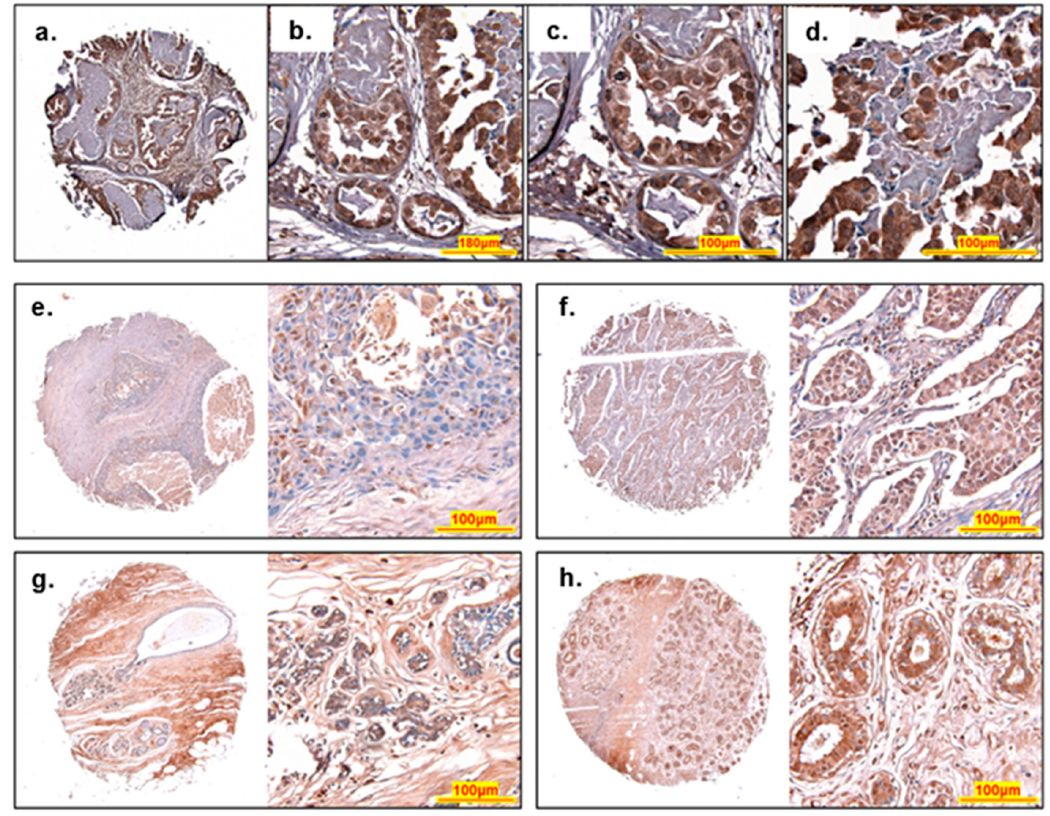
Figure 7. Histology of ACBD3 stained breast cores. ( a – d ) An invasive carcinoma from a 39-year-old female, stage IIA, ER- PR- HER2 2+ reveals a pattern of differential ACBD3 staining (brown), haematoxylin was used a as a nuclear stain (blue). ( a ) Low magnification image of entire core, fibrous interlobular tissue has a low level of ACBD3 staining whilst breast duct acini have high levels of ACBD3 staining. ( b ) Medium magnification of regular and irregular duct acini. ( c ) High magnification of regular small acini, shows high ACBD3 staining of luminal epithelial and basal myoepithelial cells. ( d ) High magnification of irregular large acini. Luminal epithelial and basal myoepithelial cells are both highly stained for ACBD3 but cells within the acini, possibly a ductal carcinoma in situ have a moderate-to-low level of ACBD3 staining, with some embedded cells with high levels of ACBD3, possibly luminal epithelial cells. ( e–h ) Typical ACBD3 staining of different cores. ( a ) Invasive ductal carcinoma of a 47-year-old female. Stage IA, grade 3, T1N0M0 scored as 1.1 overall for ACBD3 staining. ( b ) Invasive ductal carcinoma of a 50-year-old female. Stage IIA, Grade 2, T2N0M0 scored as a 2 overall for ACBD3 staining. ( c ) Normal-adjacent breast tissue with ductal ectasia of a 41-year-old female, scored 2.9 overall. ( d ) Cancer-adjacent tissue (adenosis) of a 39-year-old female, scored 1.7 overall.